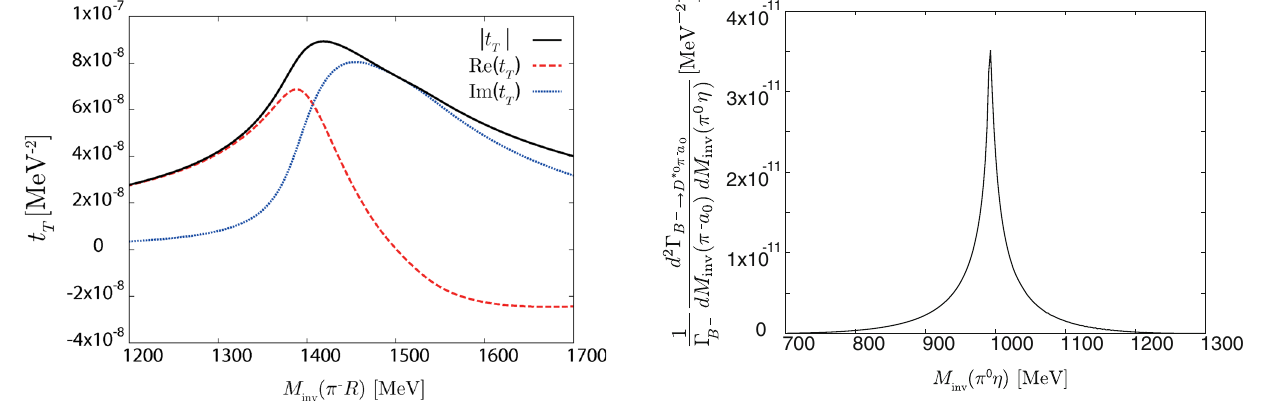
Fig. 4 Triangle amplitude t T for the decay B − → D ∗ 0 π R . We take M inv ( R ) = 980 MeV